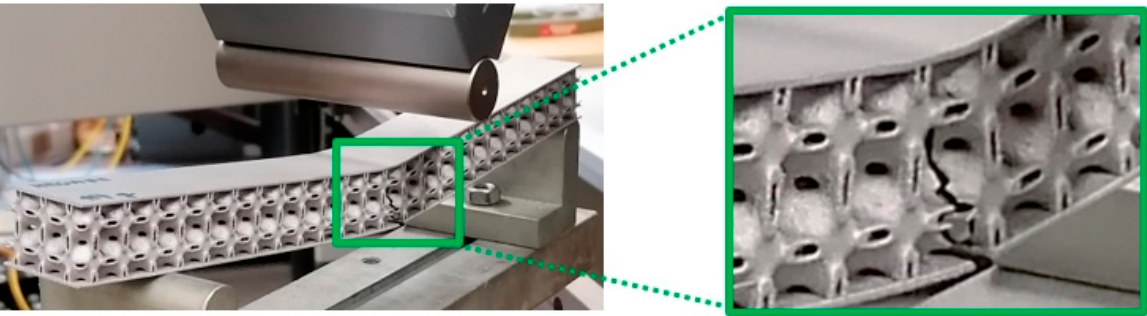
Figure 9. The sample after failure with detail of crack propagation.